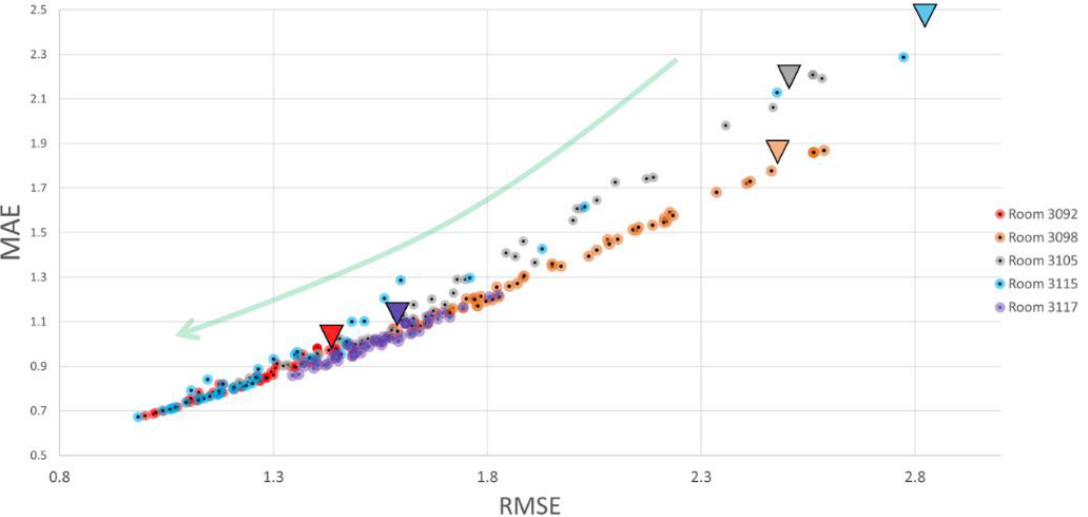
Figure 10. Results of the optimisation procedures and progressive improvements of the calibration metrics for 5 rooms in the Helios building. The triangles represent the values of the calibration metrics at the beginning of the optimisation procedure. Table 2. Calibration results for three rooms of the Helios building for the period January – March 2018.